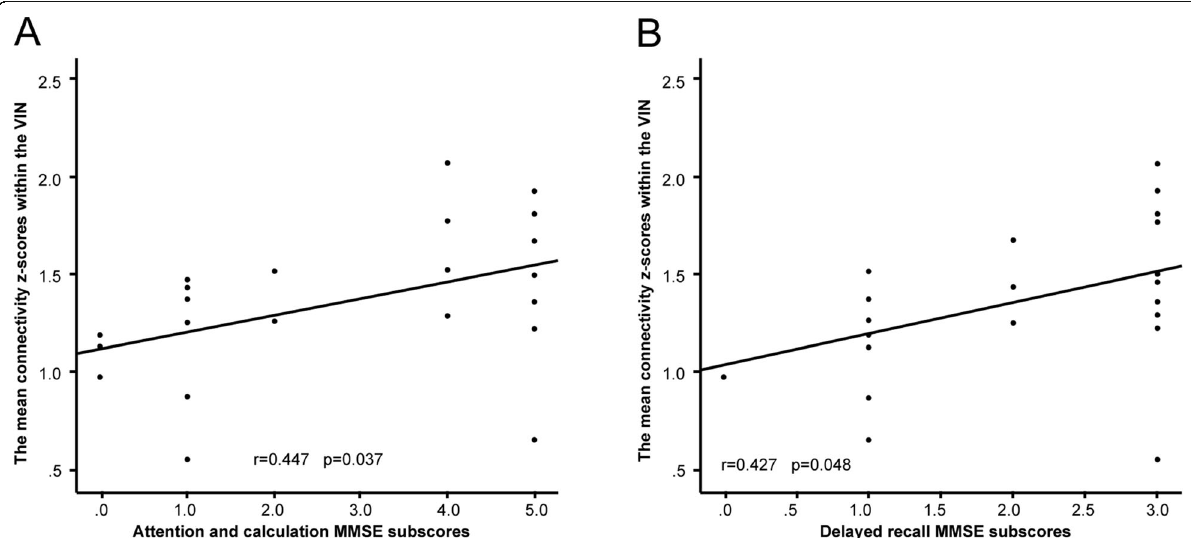
Fig. 4 Significant correlations between the mean connectivity z-scores of the LG and CU within the VIN and cognitive measures for surviving clusters in the CADASIL group. a The mean connectivity z-scores within the VIN and the attention and calculation MMSE subscores; r = 0.447, p = 0.037. b The mean connectivity z-scores within the VIN and the delayed recall MMSE subscores; r = 0.427, p = 0.048. LG: lingual gyrus; CU: cuneus; VIN: visual network; CADASIL: cerebral autosomal dominant arteriopathy with subcortical infarcts and leukoencephalopathy; MMSE: Mini-Mental State